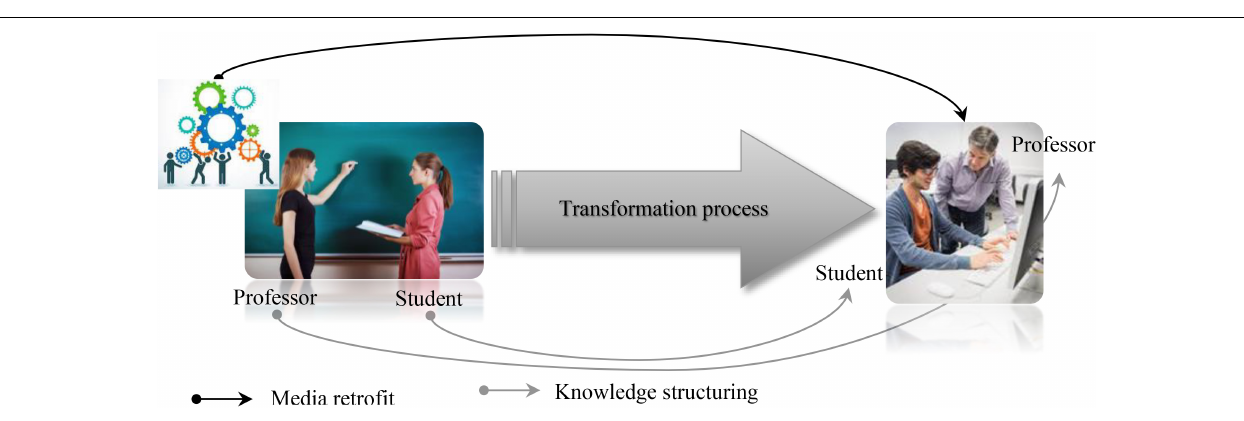
FIGURE 2 | Transformation process of educational resources based on